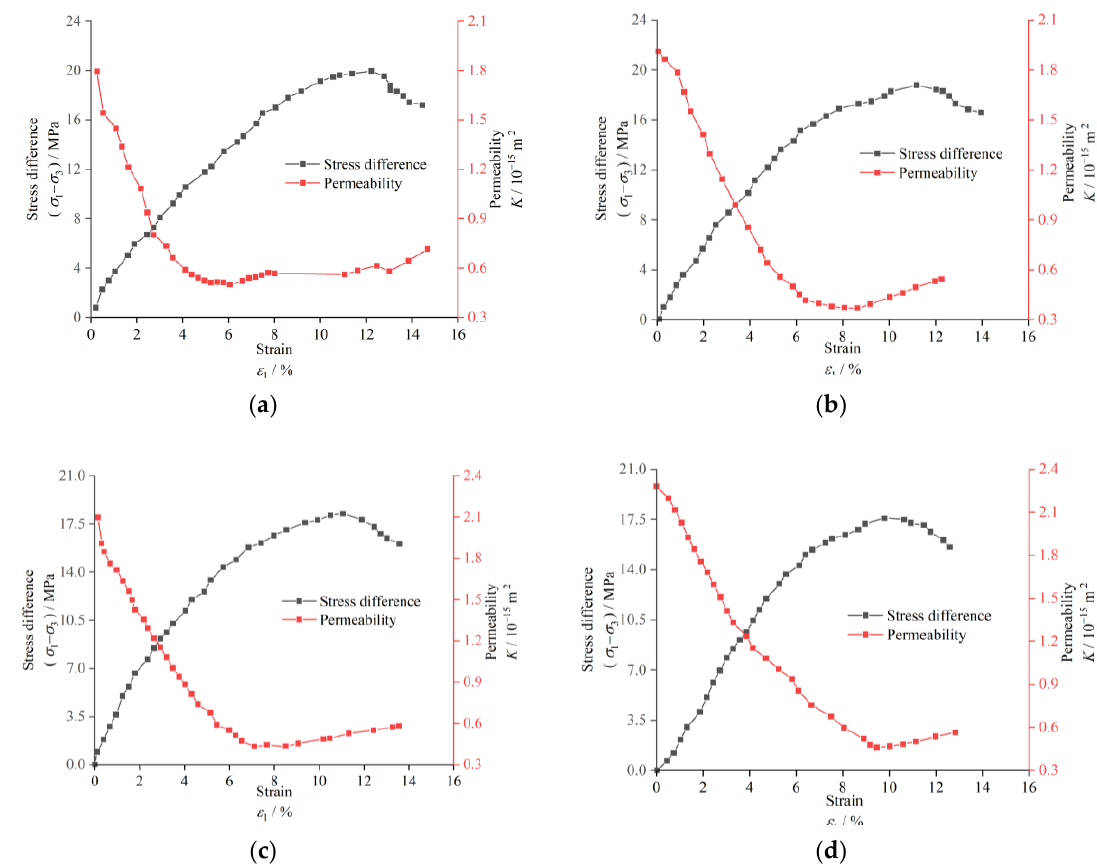
Figure 5. Curves of stress, permeability, and strain under axial compression of coal samples with constant confining pressure of 4 MPa and different gas pressures; ( a ) p = 0.5 MPa, ( b ) p = 1.0